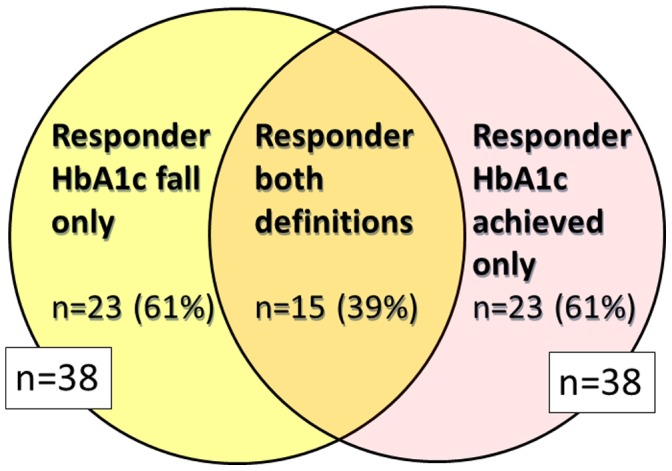
Different methods of defining good responders to glucose lowering therapy identify different individuals.Response definitions based on the top quartile of response for each method to give equal numbers of responders, n = 169.